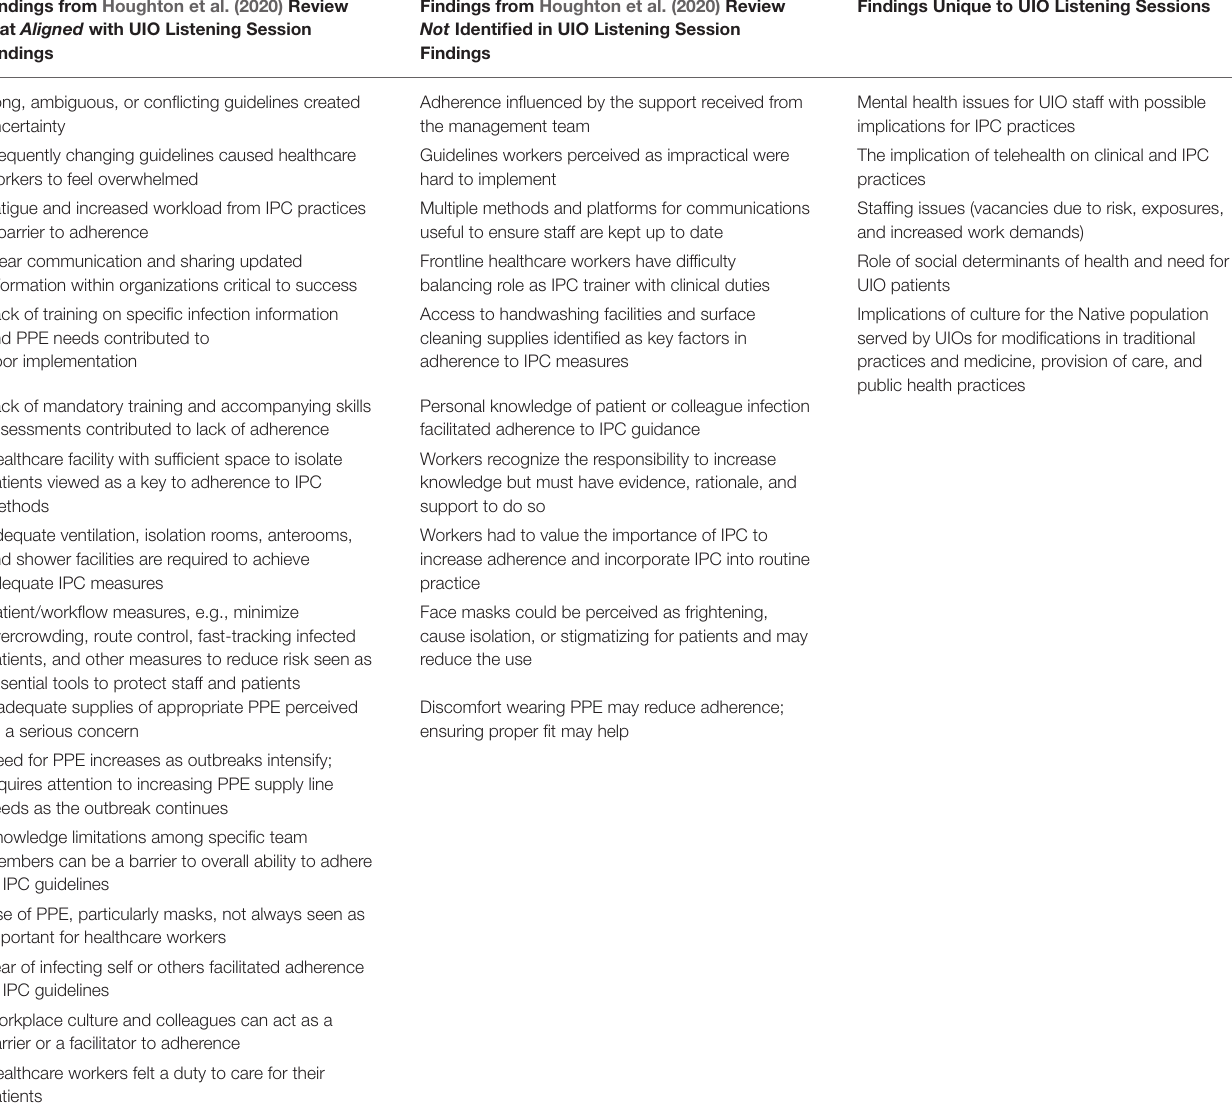
TABLE 4 | Comparison of UIO listening session findings to systematic review of barriers and facilitators to infection prevention control. Findings from Houghton et al. (2020) Review that Aligned with UIO Listening Session Findings